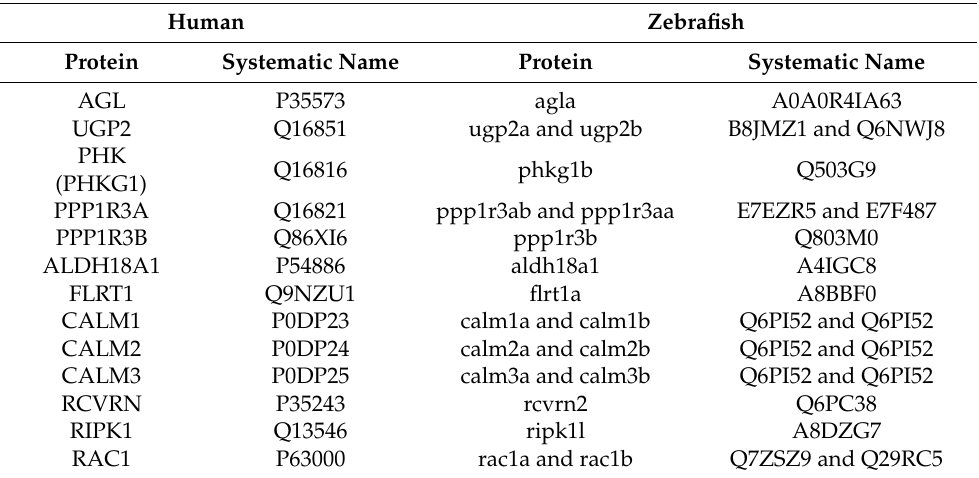
Table 1. Zebrafish ( Danio rerio ) orthologs of some human protein partners of muscle glycogen phosphorylase (PYGM). Zebrafish ( Danio rerio ) Orthologs (PYGM)